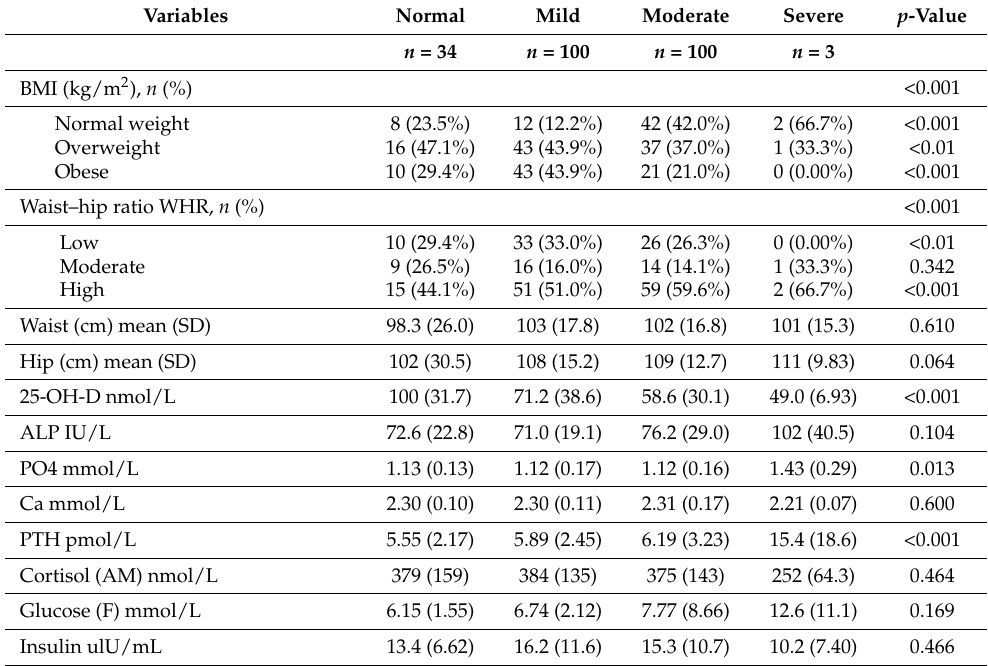
Table 3. Association between the Geriatric Depression symptom scale-15 (GDS-15), anthropometric measurements, and laboratory